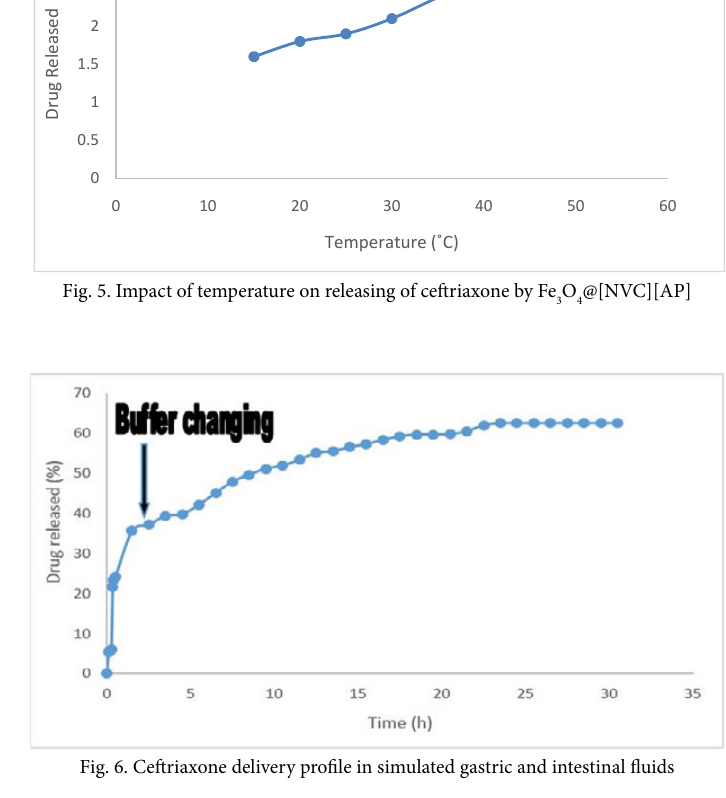
Fig. 6. Ceftriaxone delivery profile in simulated gastric and intestinal Fig. 6. ceftriaxone delivery profile in simulated gastric and intestinal fluids